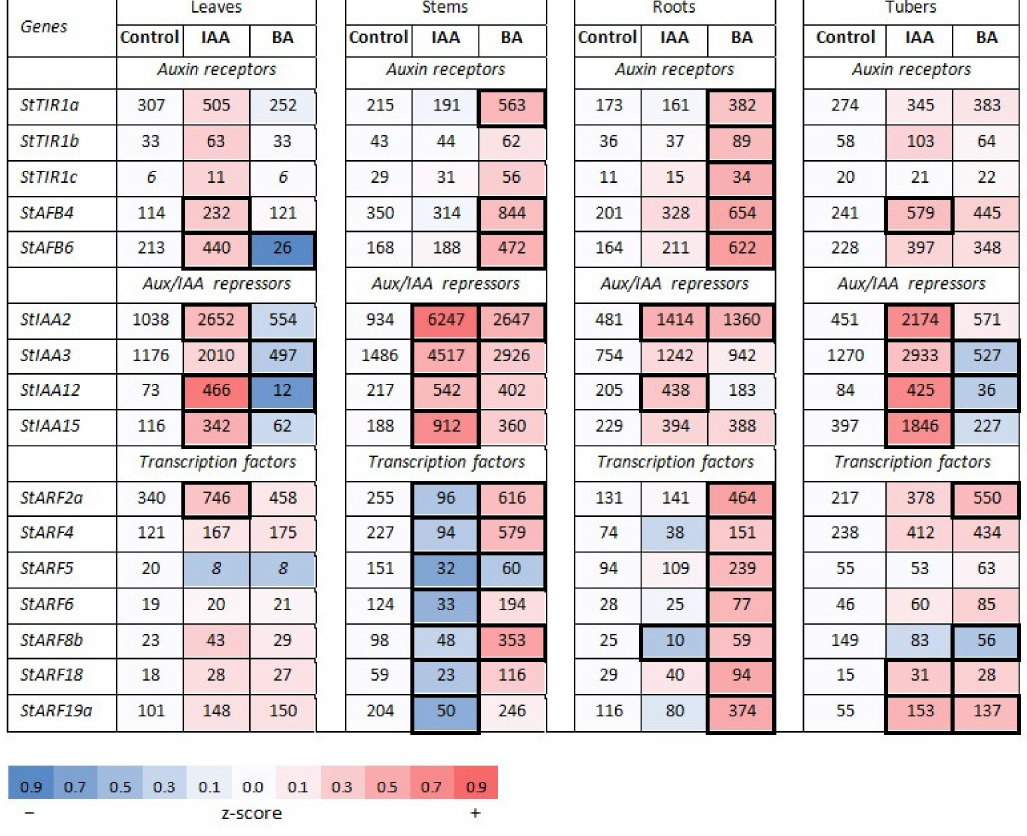
Figure 2. Effects of auxin (IAA) and cytokinin (BA) on the expression of the essential genes involved in auxin signaling in potato plants grown on medium with 5% sucrose. For heatmap details, see legend to Figure